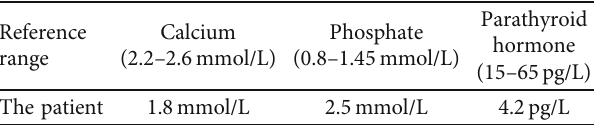
Table 1: The initial laboratory investigations of the patient. Reference